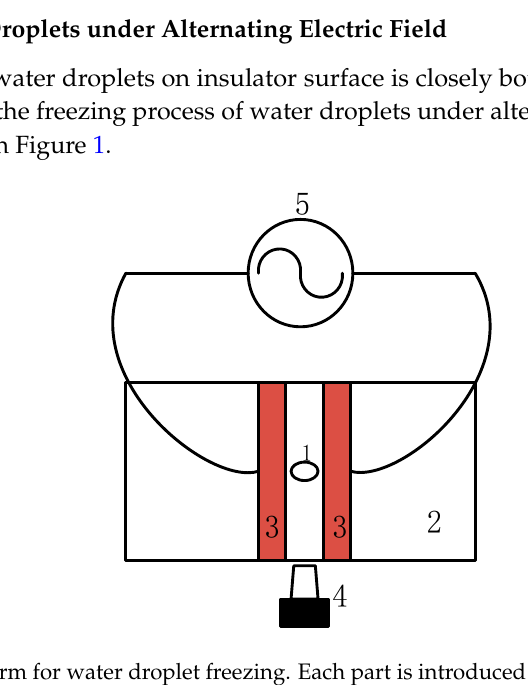
Figure 1. Test platform for water droplet freezing. Each part is introduced as follows: 1, Water drop; 2, Glass pane; 3, Copper electrode; 4, Microscope; and 5, AC Power.